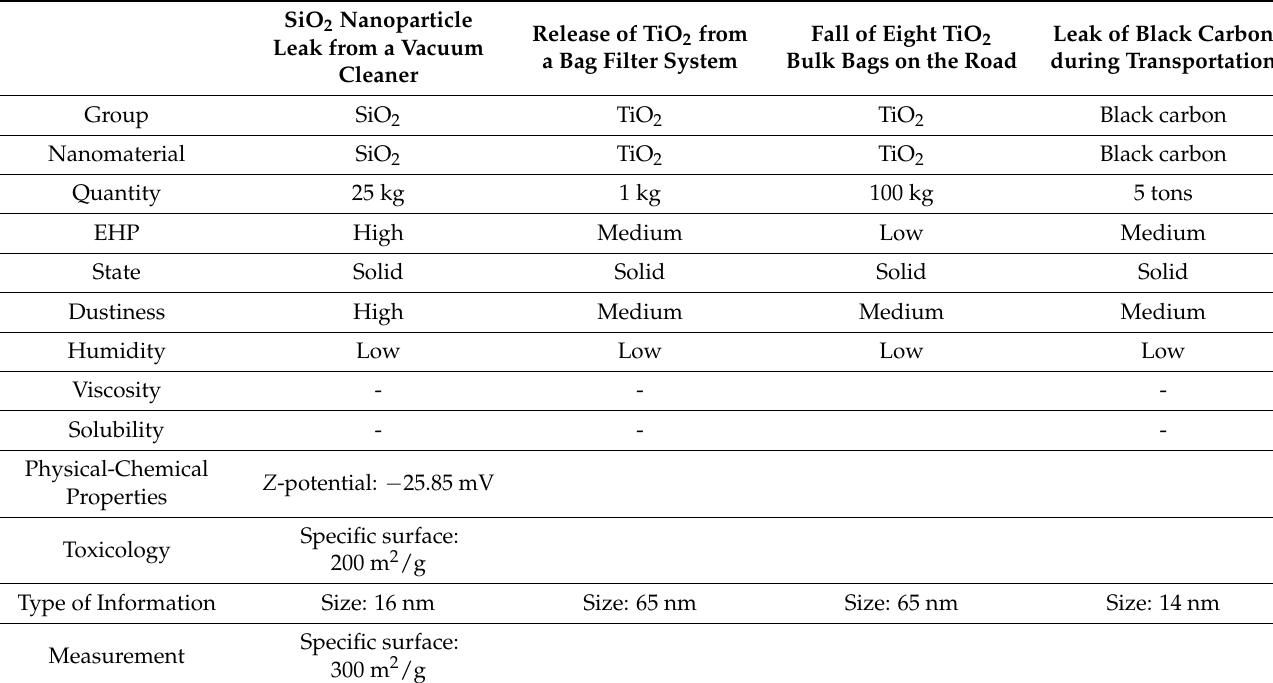
Table 8. Input data used for NanoSerpa v1.0-simulated